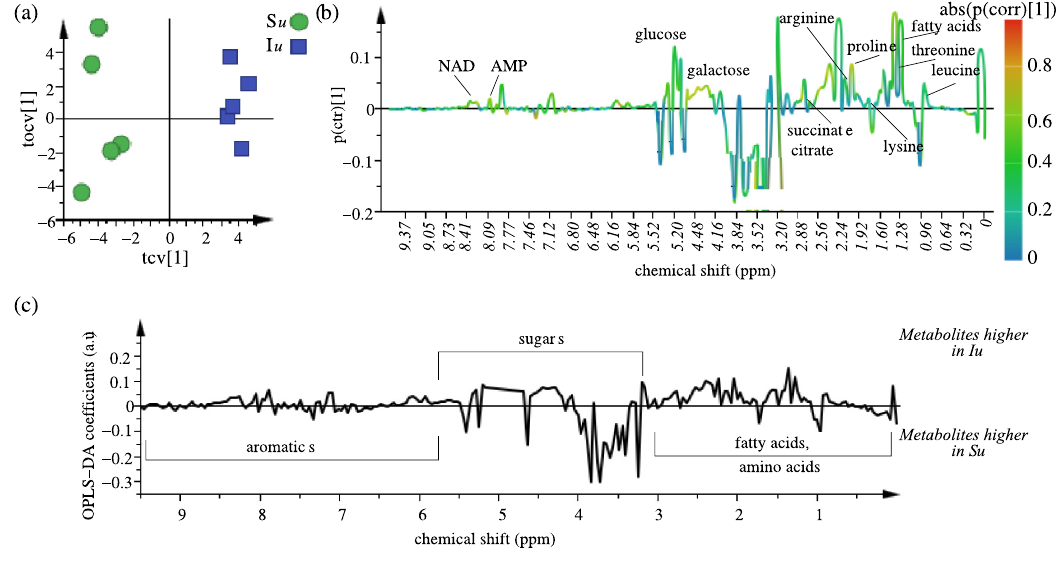
Fig 4. OPLS-DA analysis for S u and I u treatments. OPLS-DA (a) score plot and (b) loadingplot derived from 1 H NMR spectra of S u and I u treatments, with the section above0 in the loadingplot representingmetabolites higherin the I u treatment and the section below 0 in the loadingplot representingmetabolites higherin the S u treatment and (c) S-line plot visualizingdifferencesbetweenI u and S u populations.